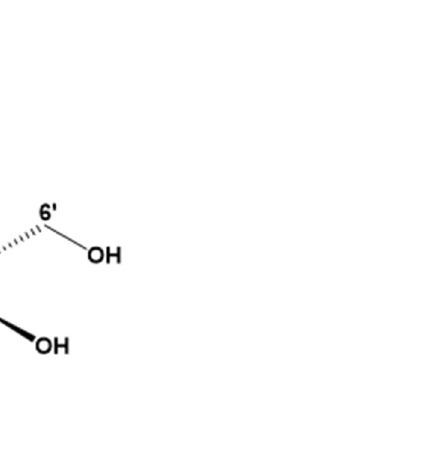
Figure 1. Structure of